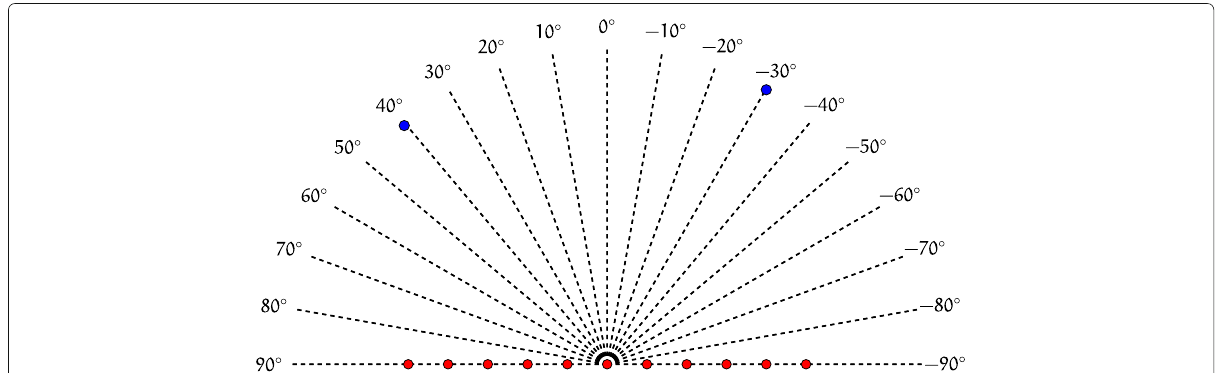
Fig. 1 The candidate DOAs in the target space. The red circles denote the microphones. The blue circles denote the positions of the sound sources